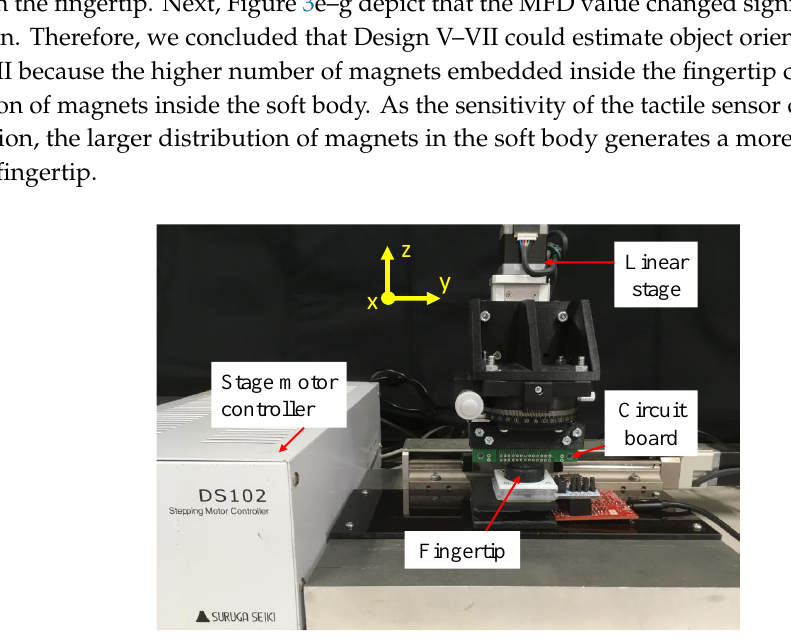
Figure 2. Experimental setup for pushing test with various soft fingertip designs.